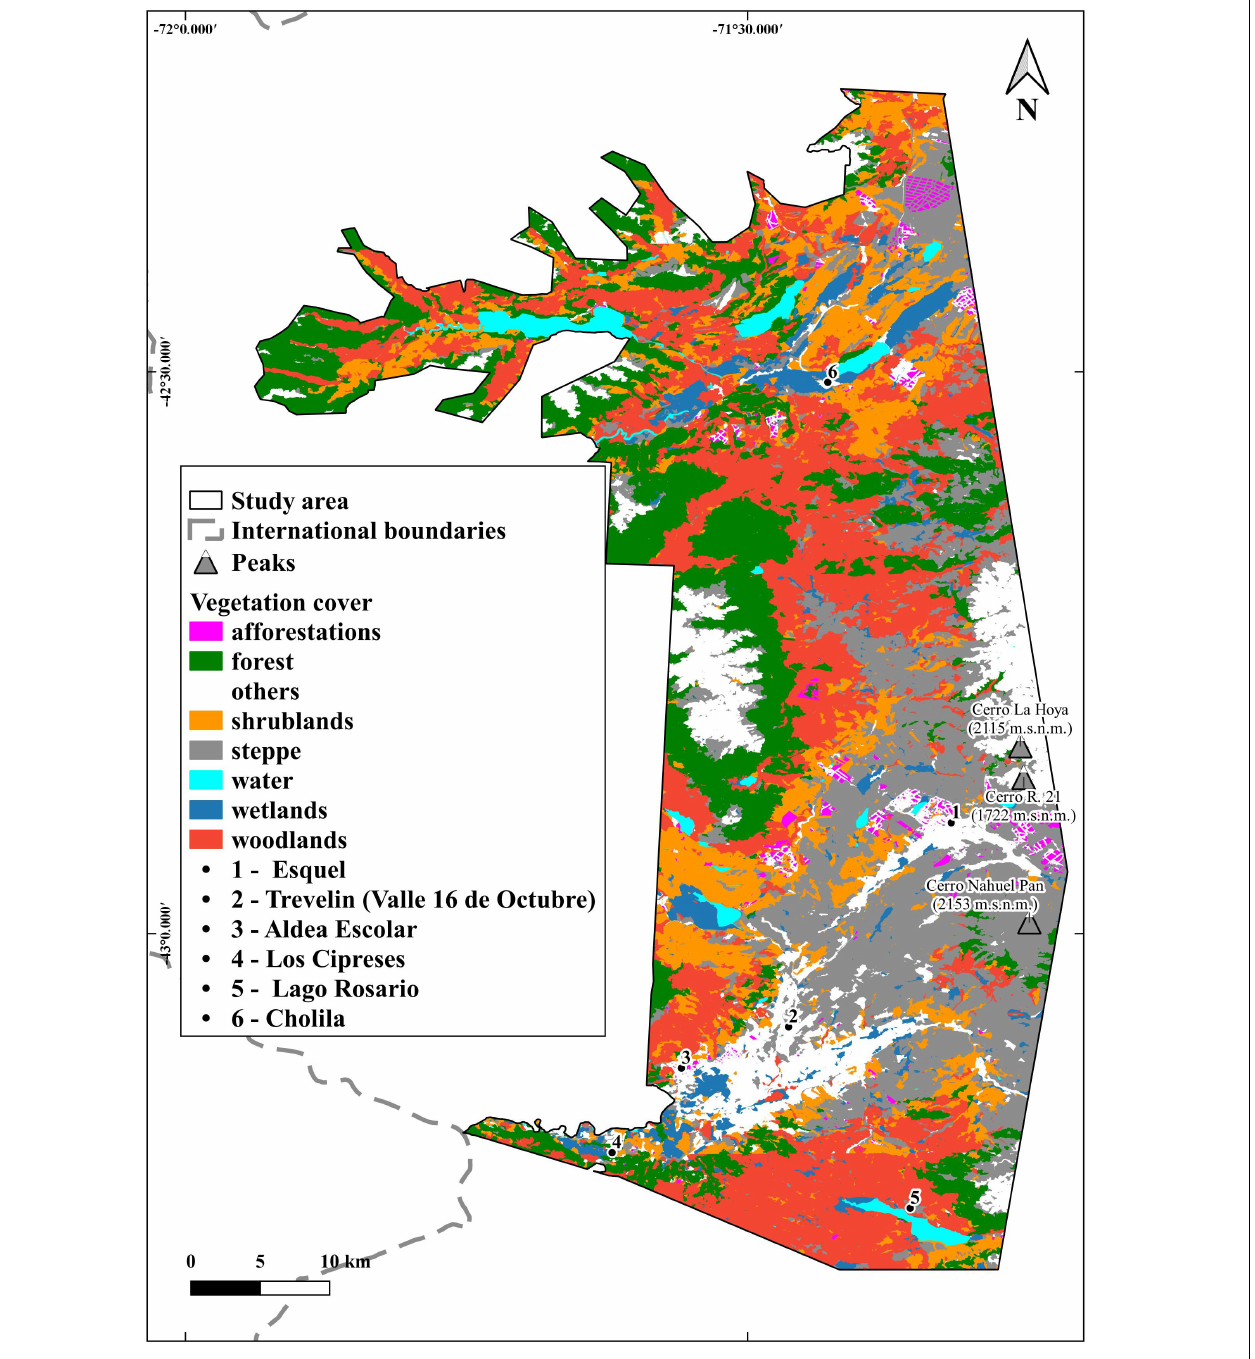
FIGURE 2 | Main vegetation types of the study area derived from CIEFAP and MAyDS (2016) main vegetation types of the study area. Forests are Austrocedrus chilensis–Nothofagus forests. Afforestations are Ponderosa pine forests. Woodlands are open areas dominated by N. Antarctica trees and surrounded by scattered shrubs and bushes. Steppe are areas dominated by grasses. Others is the area occupied by the villages, towns, agricultural and pasture lands, rocks, and high peaks without vegetation. Shrublands is the area dominated by low-dense shrub vegetation.